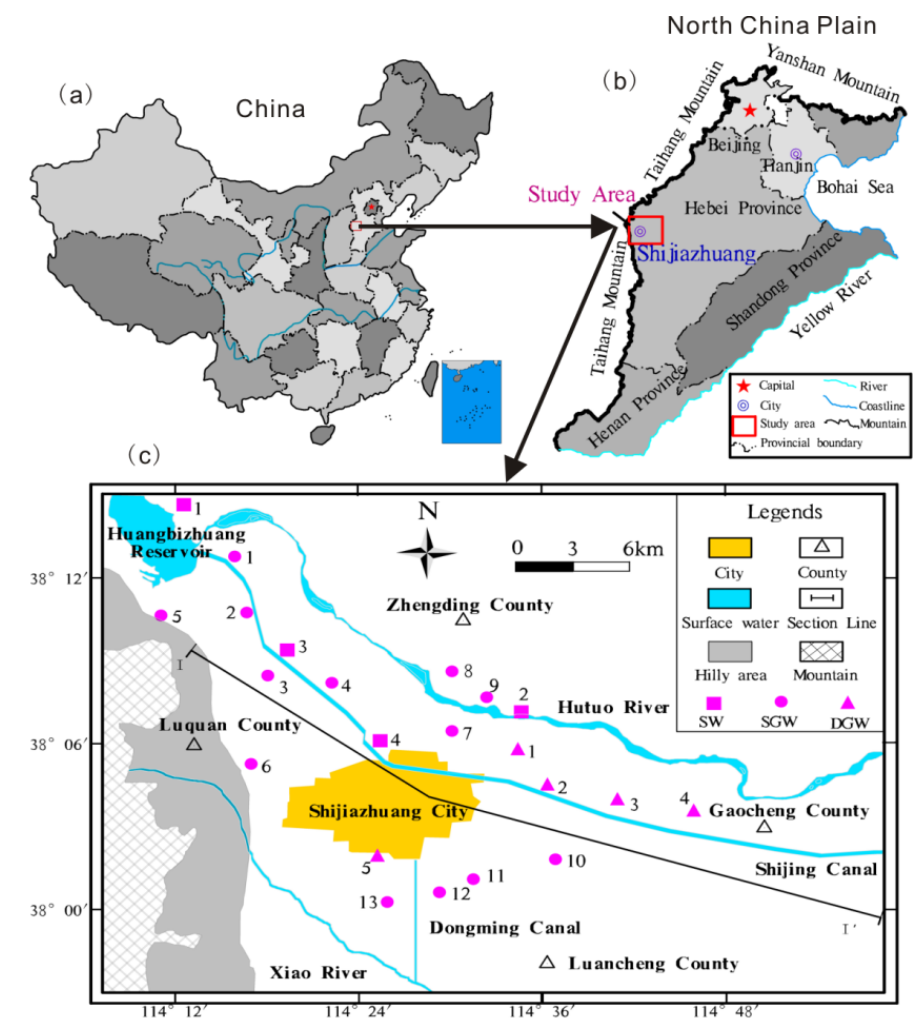
Figure 1. Illustration of the study area and sampling points. ( a , b ) are location maps of the study area; and ( c ) sampling map. Line I–I' indicates location of hydrogeologic cross section in Figure 2. (SW: Surface water; SGW: Shallow groundwater; DGW: Deep